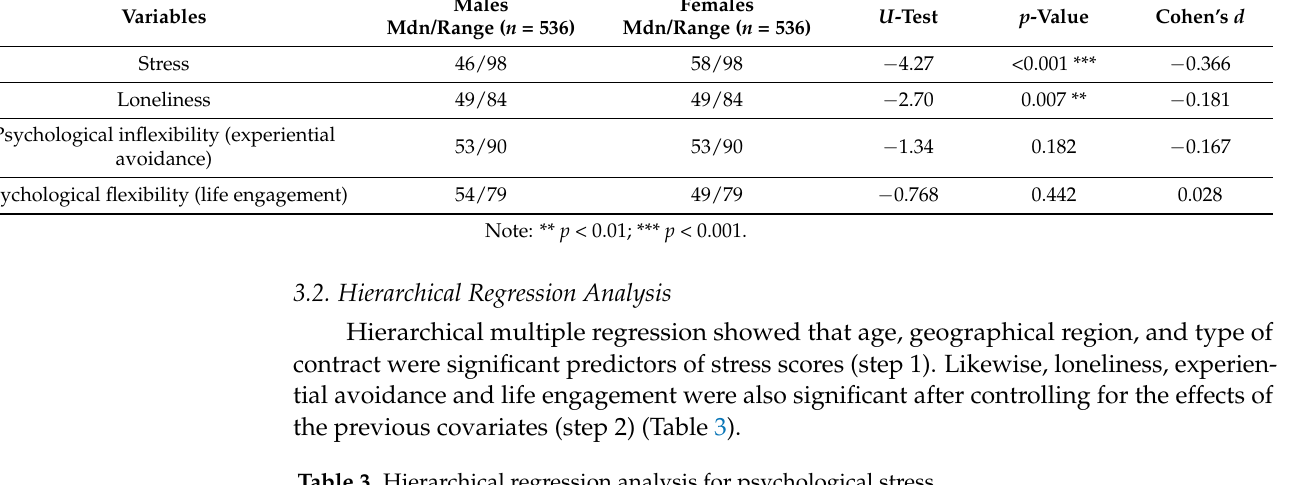
Table 3. Hierarchical regression analysis for psychological